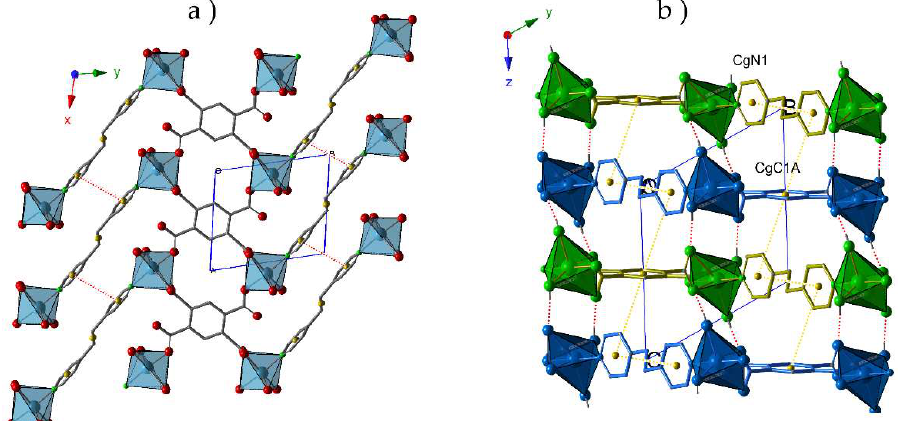
Figure 1. ( a ) View of the hybrid layers in 1 parallel to the (01–2) plane. The π - π interactions are depicted as red dotted lines; ( b ) View of the staking of the layers along the x axis. Hydrogen bonds are represented as red dotted lines, whereas the interactions between aromatic rings are depicted as yellow dotted lines. CgN1: N1, C2, C3, C4, C5, C6; CgC1A: C1A, C2A, C3A, C1A_d, C2A_d, C3A_d. Table 2. Distances (Å) and angles ( ◦ ) of supramolecular hydrogen bonding and π - π interactions in 1 . D-H ··· A